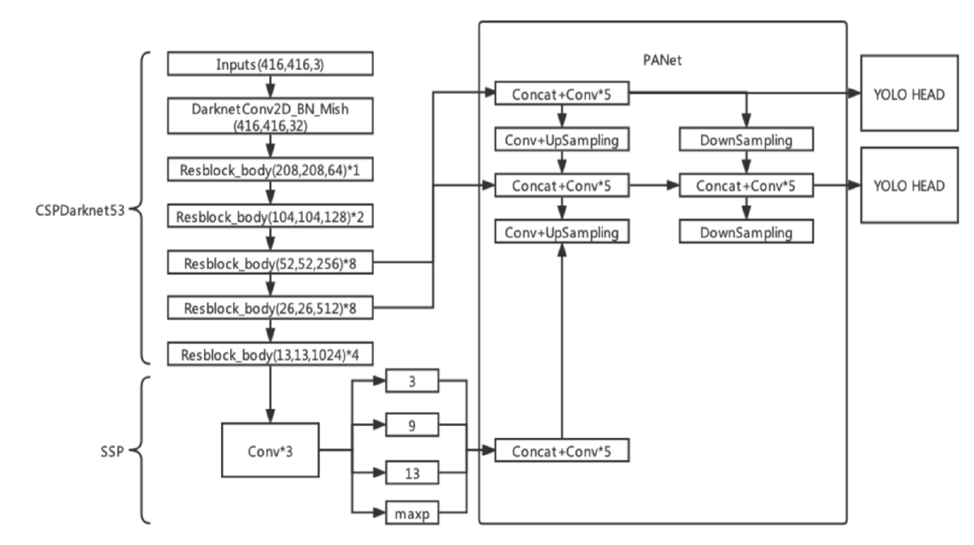
Figure 4. Improved YOLOv4 structure.